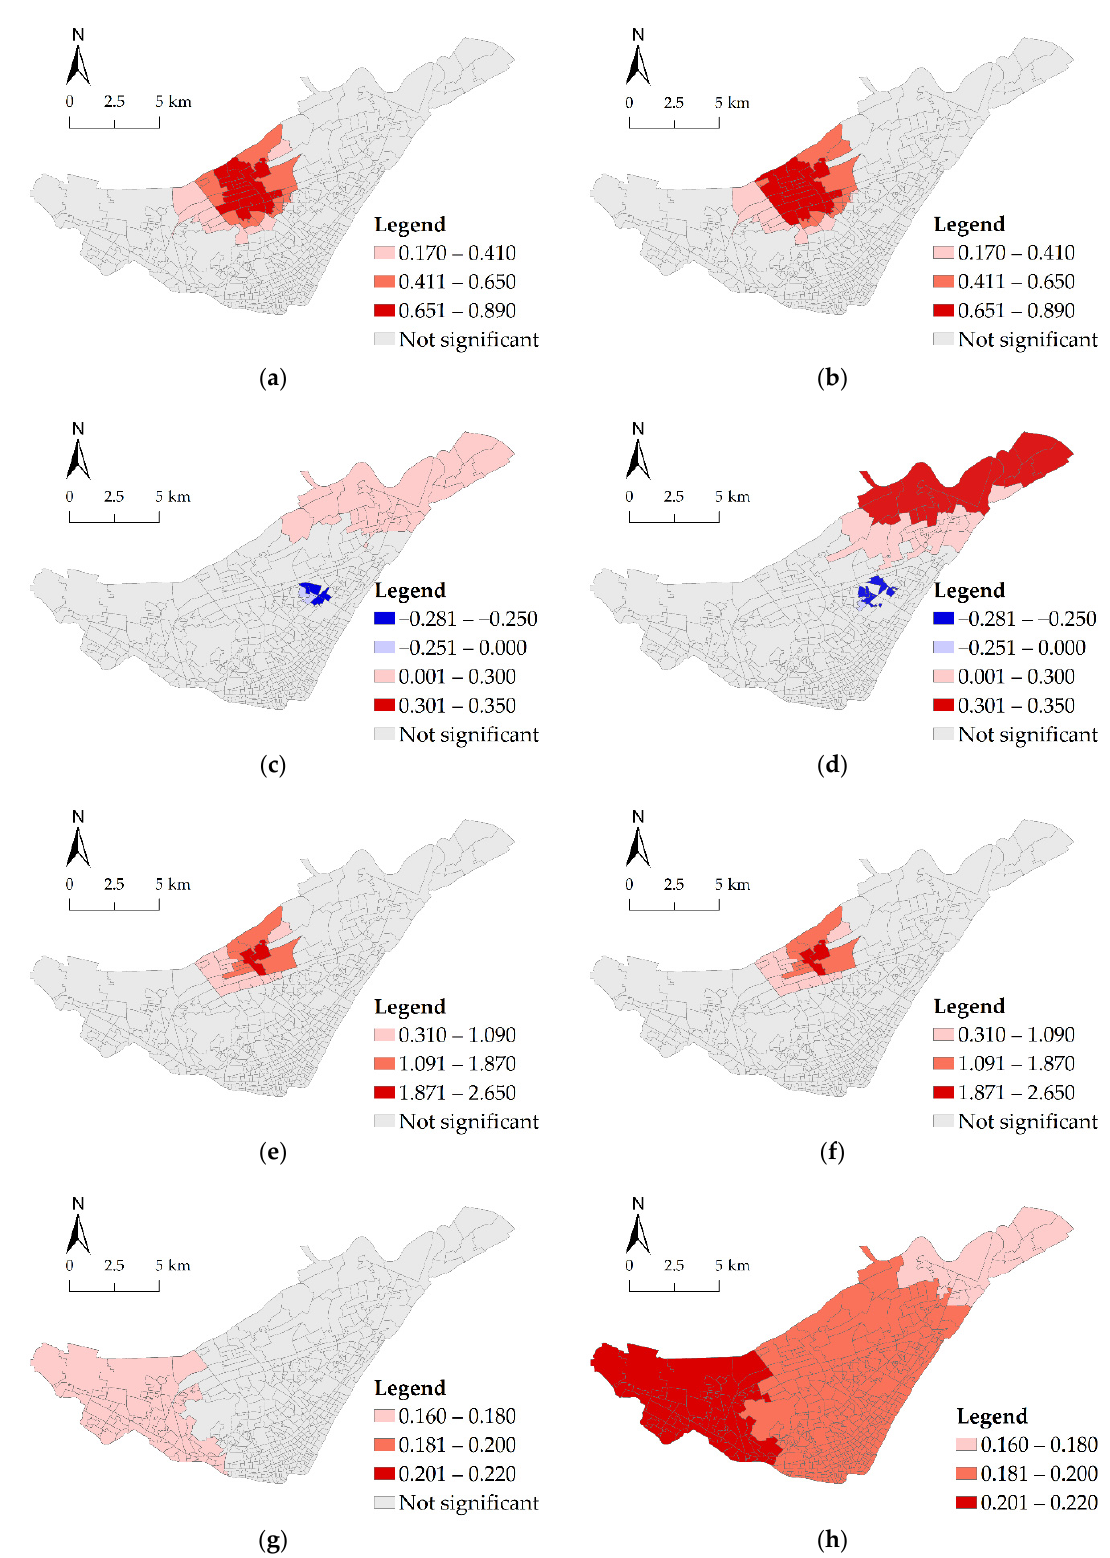
Figure 5. The spatial distribution of local coefficient estimates from MGWR models. ( a ) Model9 results for commercial service POI; ( b ) Model10 results for commercial service POI; ( c ) Model9 results for industrial POI; ( d ) Model10 results for industrial POI; ( e ) Model9 results for public service POI; ( f ) Model10 results for public service POI; ( g ) Model9 results for transportation POI; ( h ) Model10 results for transportation POI.